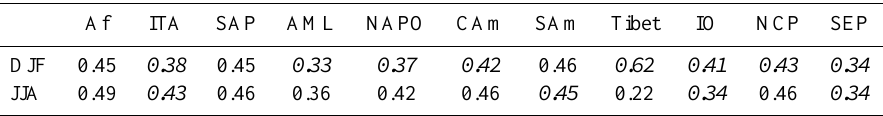
Table 3. Ratio of transport efficiency between forward calculations without cloud top offset and with a +1km cloud top offset. The ratio is averaged over DJF and JJA for the 2005–2008 period and all regions. The values for weakly contributing regions, excluded from Tables 1 and 2, are based on a small number of events and are italicized.